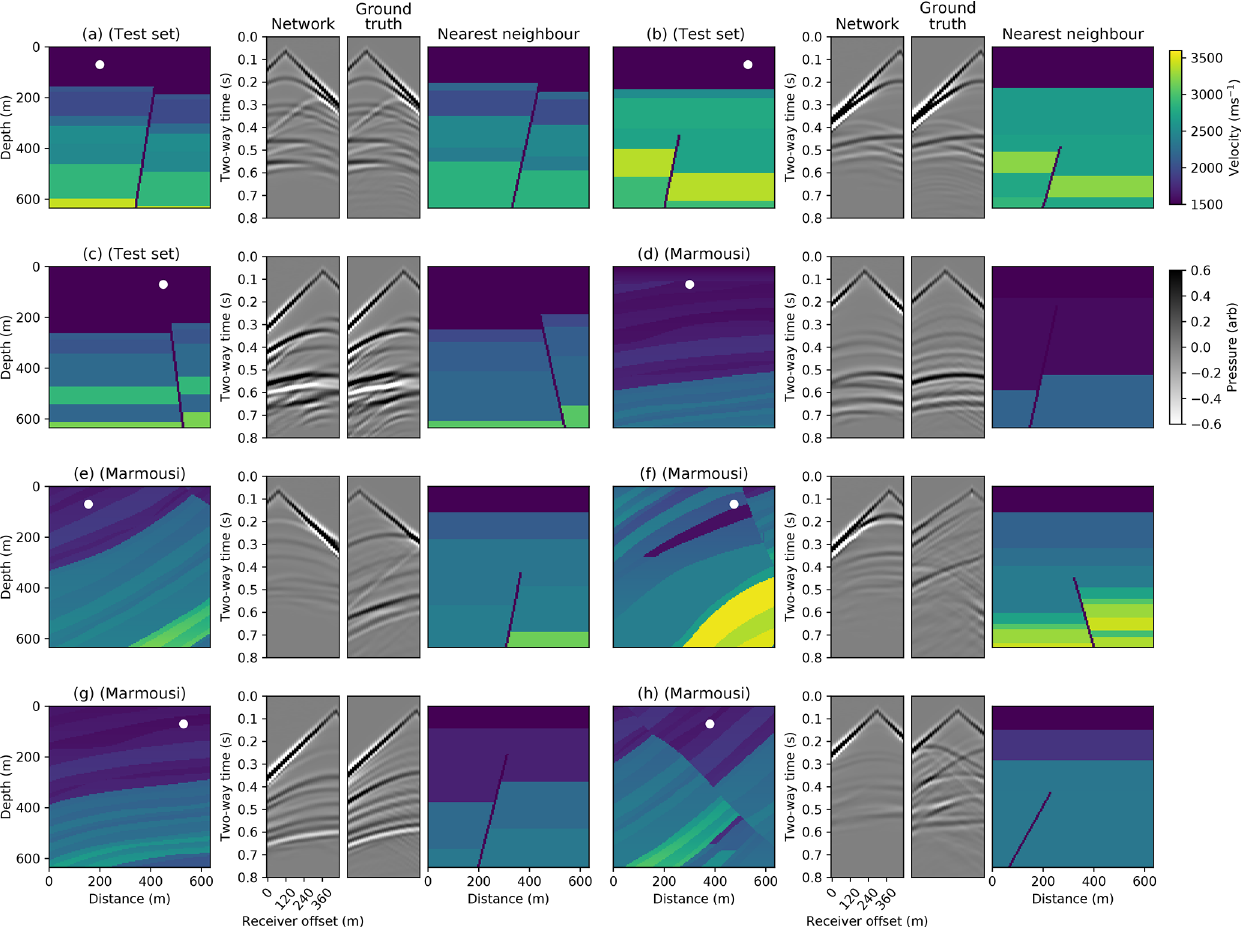
Figure 11. Generalisation ability of the conditional autoencoder. The conditional autoencoder simulations for five velocity models taken from different regions of the Marmousi P-wave velocity model are shown (d–h) . For each example, the left plot shows the input velocity model and source location, the middle simulation plots show the network prediction (left) and the ground truth FD simulation (right), and the right plot shows the nearest neighbour in the training set to the input velocity model. Simulations from three of the test velocity models in Fig. 9 are also shown with their nearest neighbours (a–c) . A t 2 . 5 gain is applied for